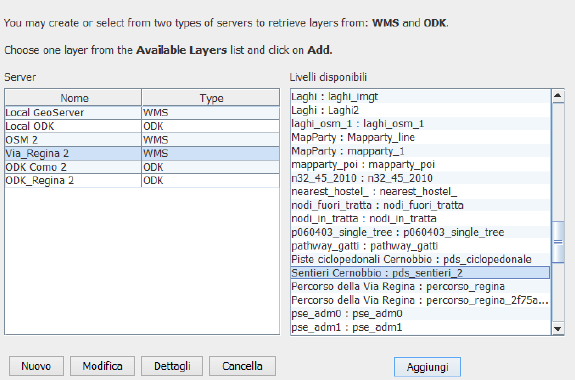
Figure 7. WMS/ODK server list (left panel) and corresponding layer list (right panel)